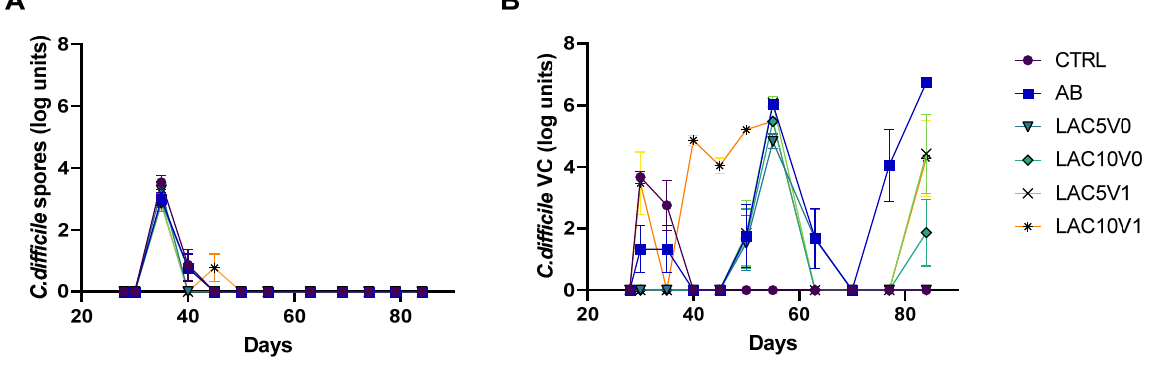
Figure 2. C. difficile spore counts ( A ) and viable cell (VC) counts ( B ) quantified by plating during the course of the control period (C; d28), the clindamycin treatment period (CLI; d30), the CDI stabili- zation period (d35–55), the vancomycin treatment period (VNC; d63) and the post-intervention pe- riod (PI; d70–84) of the PathoGut™ SHIME experiment in the distal colon reactors for six of the experimental arms, including arm 1 (CTRL), arm 2 (AB), arm 5 (LAC5V0), arm 6 (LAC10V0), arm 7 (LAC5V1) and arm 8 (LAC10V1). Dots represent mean ± SEM ( n = 3) at different time points of the experiment. Two-way ANOVA was used to calculate statistically significant differences between the experimental test arms, with significance highlighted in the text ( p <